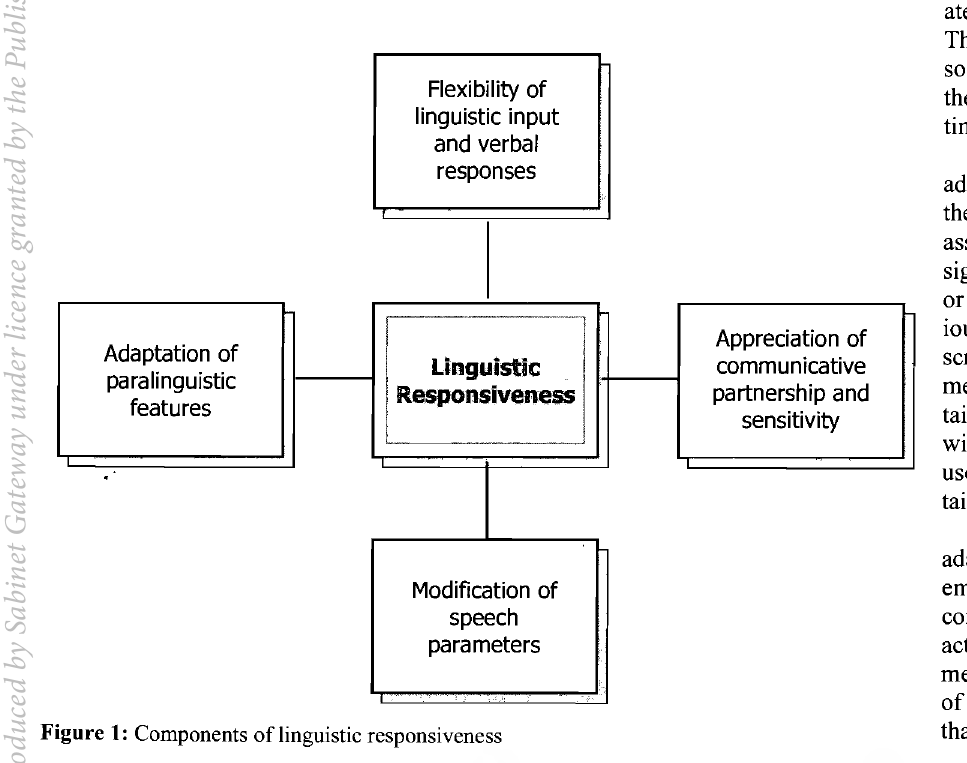
Figure 1: Components of linguistic responsiveness Die Suid-Afrikaanse Tydskrif vir Kommunikasieajwykings, Vol. 54,